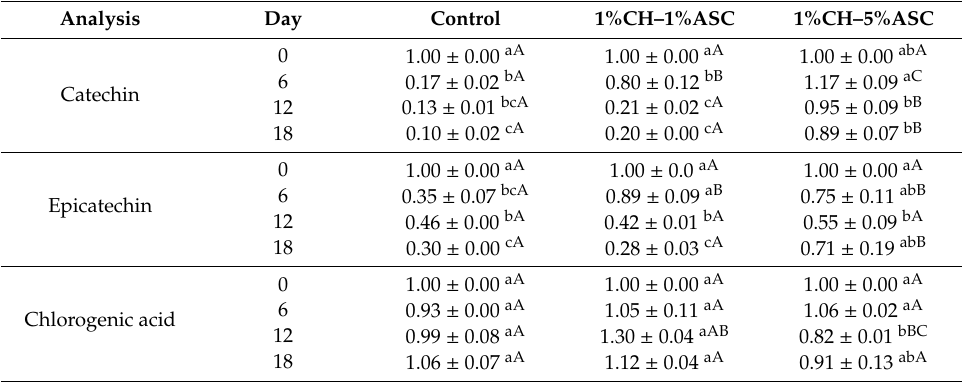
Table 3. Changes in the dimensionless concentrations (C/C o ) of certain phenolic compounds in fresh cut apples during storage at 5 ° C*.